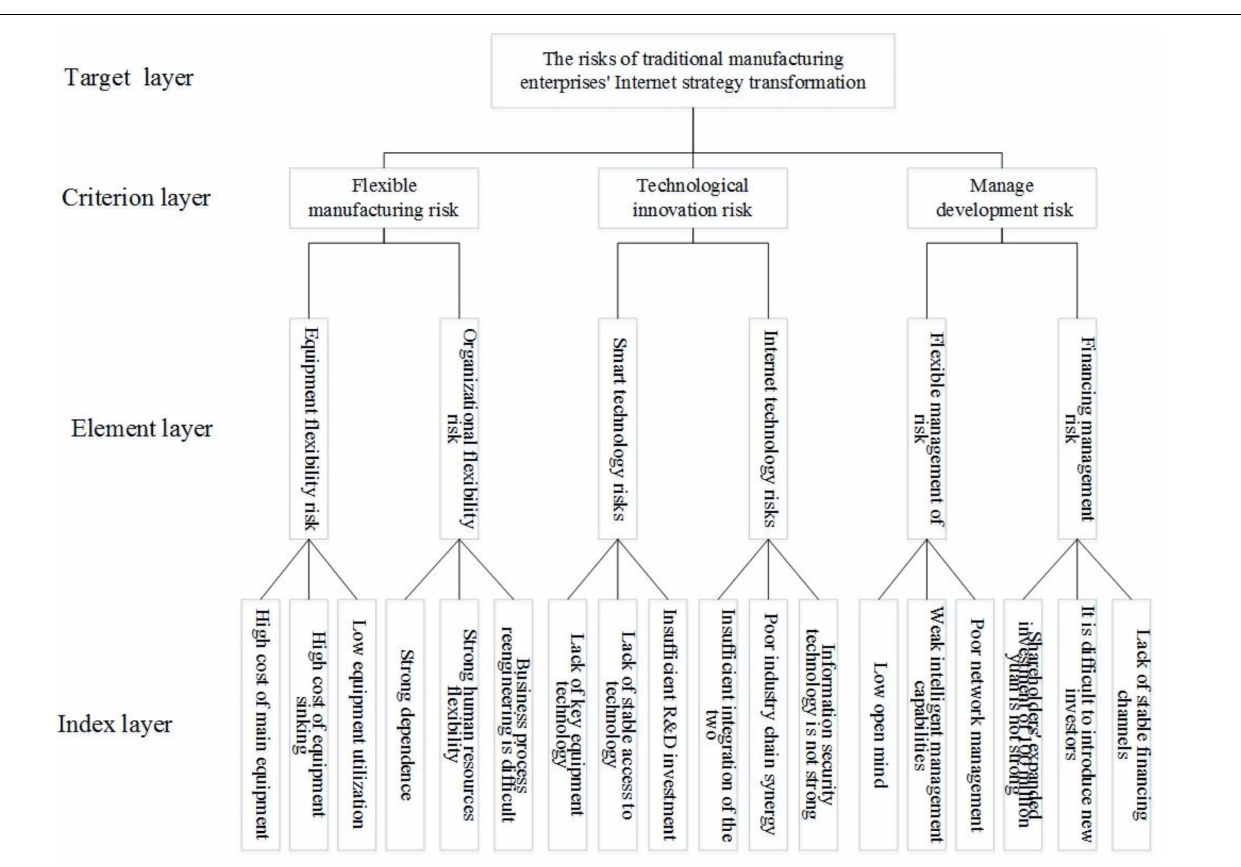
FIGURE 1 | Structural diagram of the risk evaluation index system for the Internet strategic transformation of manufacturing